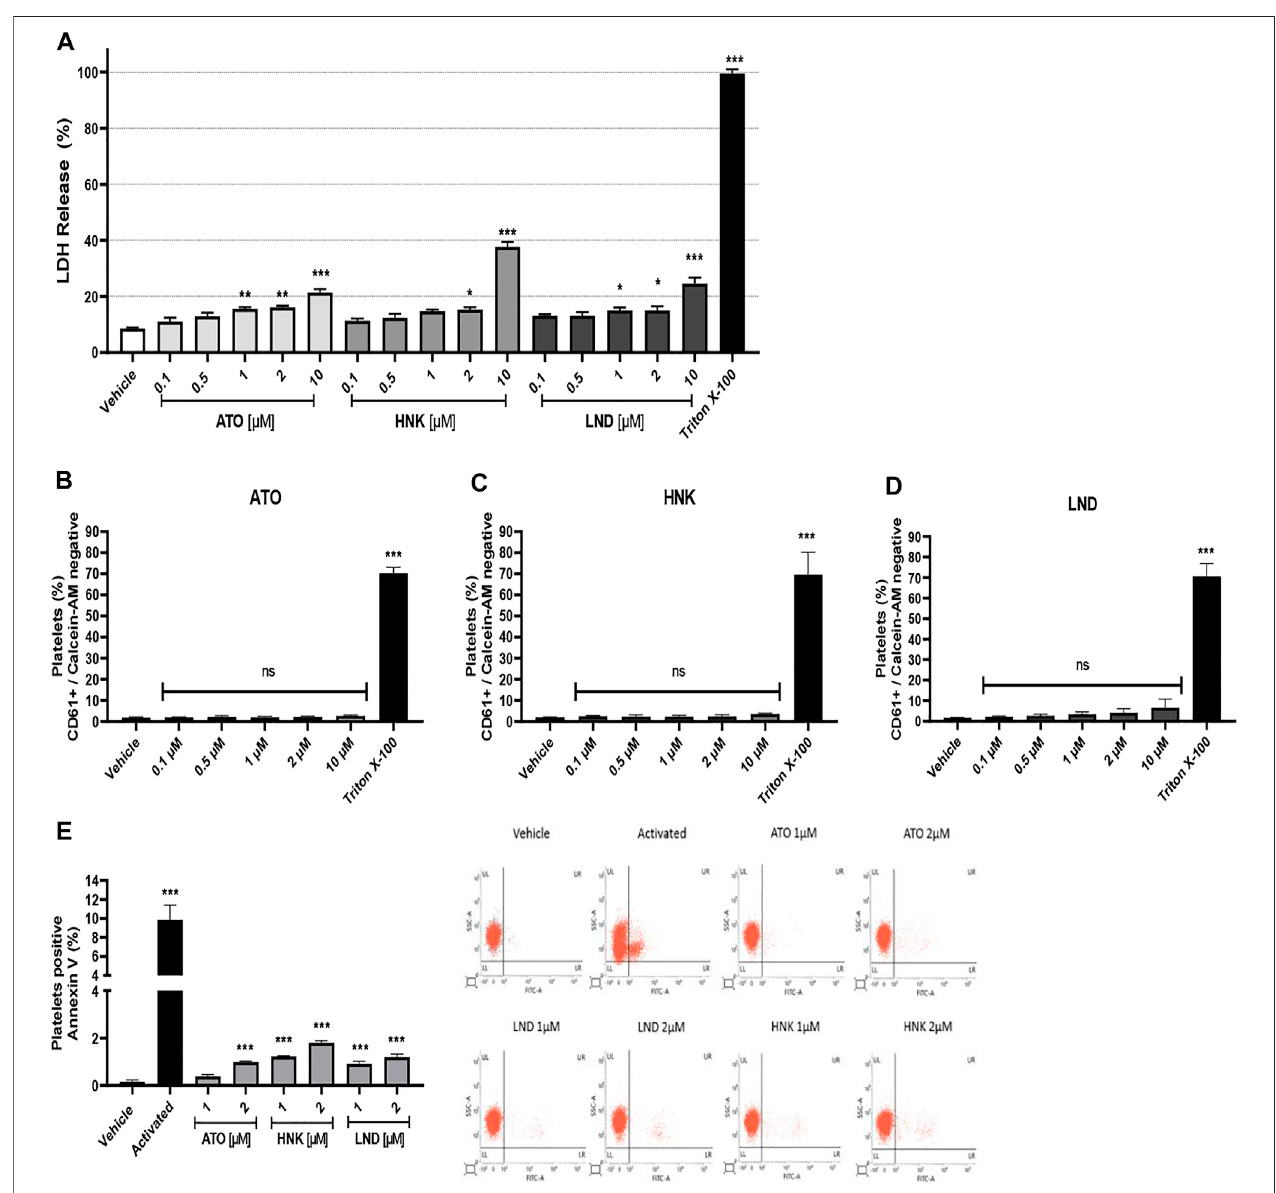
FIGURE2| Cytotoxiceffectandprocoagulantactivity(exposureofphosphatidylserine). (A) LDHreleasefromplatelets, (C – E) plateletviabilitystudiedwithCalcein- AM,and (E) procoagulantactivitybyannexinVbindingandrepresentativedotplotsfrom fl owcytometry.TheresultswereobtainedbyLDHreleasefromthesupernatant onwashedplateletsandevaluatedby fl owcytometry.Forviability,plateletswerestainedwithCD61antibodyandCalcein-AM,andthesubpopulationofCD61+/Calcein- AM negative was considered non-viable as it was analyzed in terms of change in the mean fl uorescence intensity from the vehicle. For procoagulant activity, the washedplateletswereincubatedwithAnnexinVFITC;thepositivecontrolcorrespondstoplateletsactivated withconvulxinandTRAP-6. Theresults wereexpressedas mean ± SEM. Vehicle: DMSO 0.4%. The statistical analysis was performed using a one-way analysis of variance (ANOVA) and the Bonferroni post hoc test. p p < 0.05, pp p < 0.01, and ppp p < 0.001 vs. vehicle. ns: not signi fi